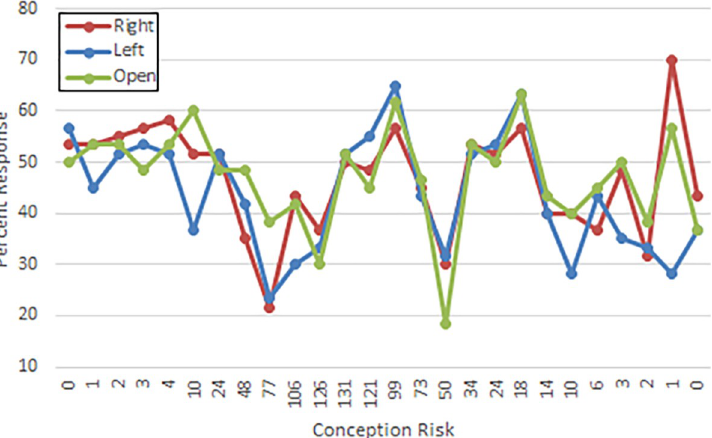
Fig 4. Percentage of right ear responses as a function of risk of conception. Mean percentage of right ear responses at each conception risk level across the month for the forced right ear, forced left ear, and open conditions.